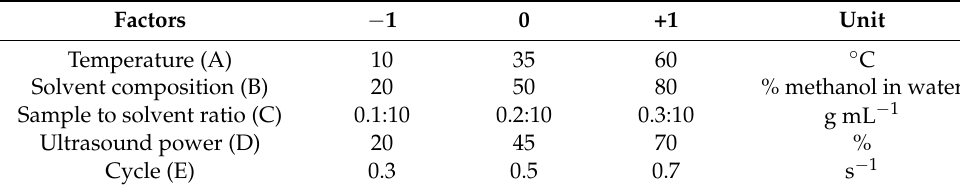
Table 1. Range of values of the independent factors.